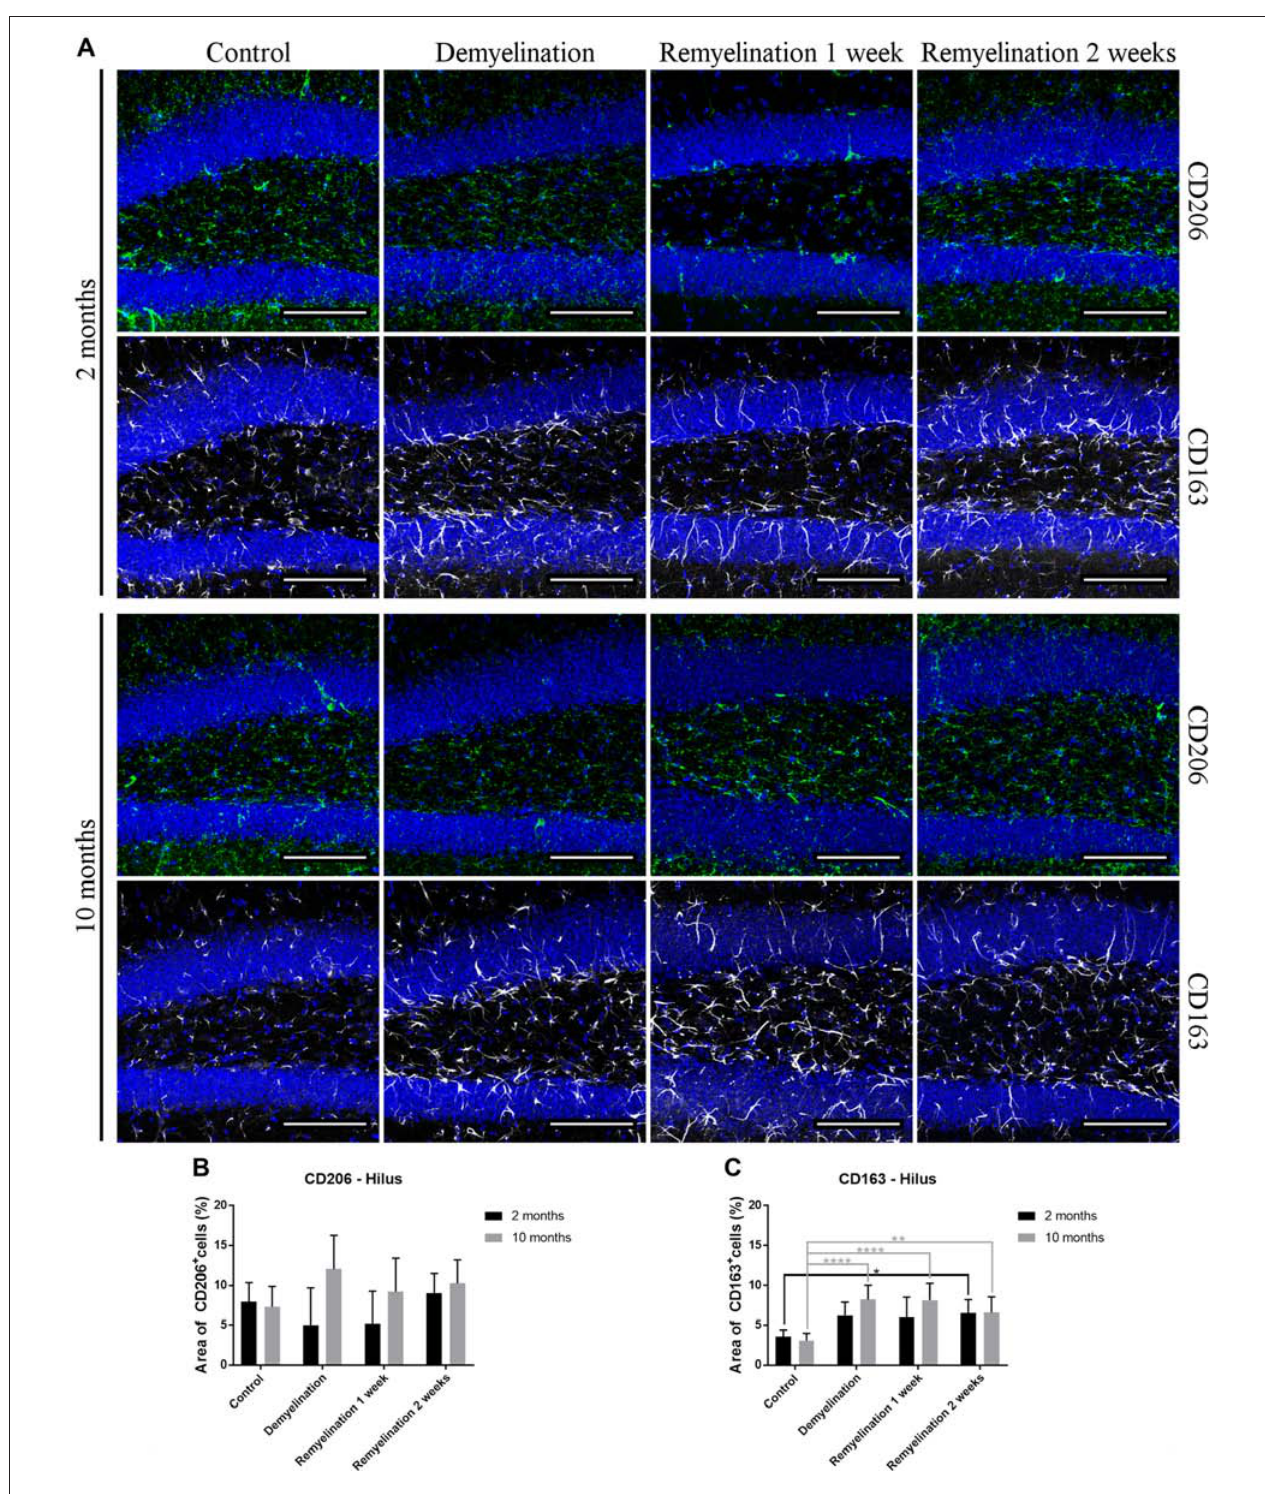
FIGURE 9 | Age-related differences in cuprizone-induced increase of CD163 in the hilus of the hippocampal DG, while CD206 is unchanged. (A) CD206 (green) and CD163 (white) labeling. Cell nuclei are stained with DAPI (blue). (B) In both age groups, de- and remyelination did not significantly affect CD206 staining. (C) In the middle-aged group, CD163 was significantly upregulated during de- and remyelination. In the younger group, the CD163 increase was only significant 2 weeks after remyelination. Values are shown as means + SD ( n = 6 per group). Statistical significance was evaluated using a two-way ANOVA followed by a Tukey’s post hoc test (C) . The p -values are indicated in the graphs: treatment effects within the same age group: ∗ p < 0.05, ∗∗ p < 0.01 and ∗∗∗∗ p < 0.0001. Bars: (A) 100 µ m.